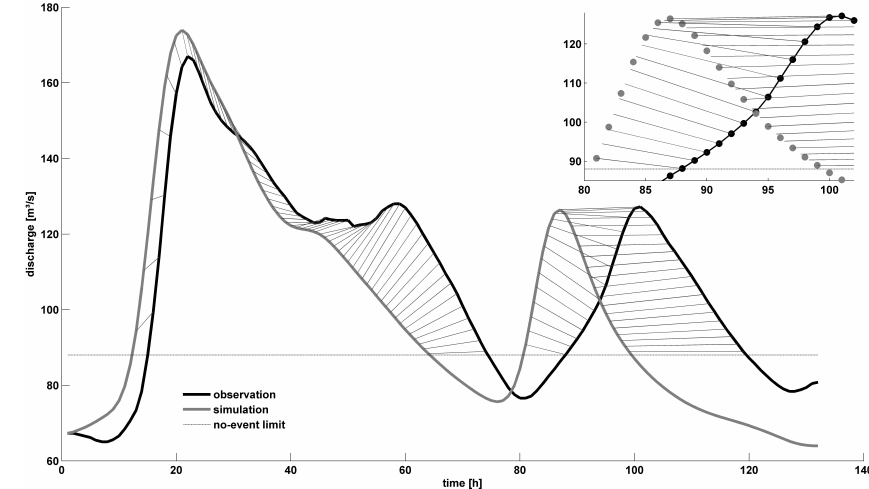
Fig. 6. Example of a matching observed (black) and simulated (grey) event (event 5 in Fig. 4). Connections (thin grey lines) between matching points of observation and simulation according to the Series Distance procedure are shown. The small inserted figure reveals that the observed points in a segment (rise or recession) do not necessarily match with a simulated point, but with a point on a polygon line representing the simulation at the same fraction of overall segment